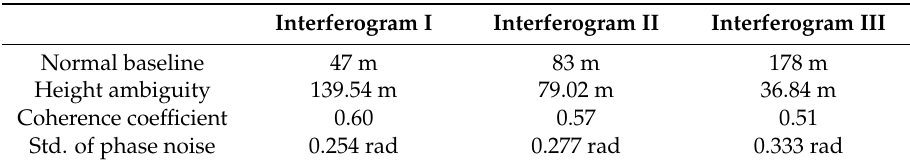
Table 2. The simulation parameters of the